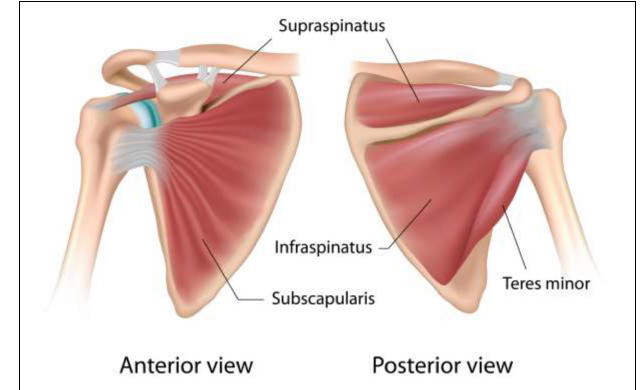
FIGURE 1 | Anatomy of rotator cuff (Micallef et al.,